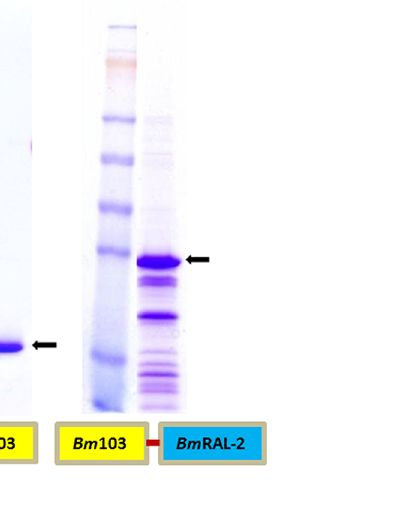
Fig 1. SDS-PAGE of purified Brugia malayi recombinant proteins, Bm -RAL-2, Bm -103 and Bm -RAL-2 — Bm -103 fusion protein. Two μ g of each protein was loaded in SDS-PAGE along with SeeBlue pre-stained protein marker (Invitrogen, USA). (A) Bm -RAL-2; (B) Bm -103; (C) Bm -RAL-2 — Bm -103 fusion protein.